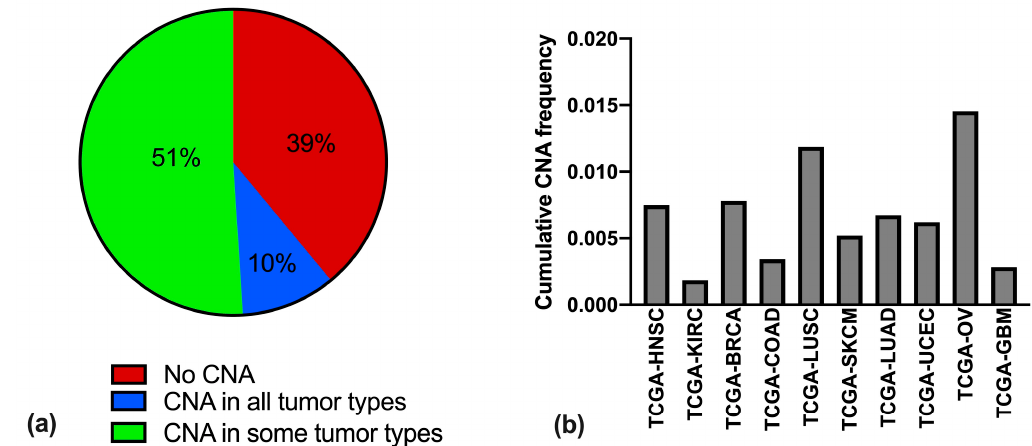
Figure 1. Occurrence of snoRNA / host gene alterations in the ten groups of cancers. ( a ) Percentage of copy number alterations (CNA) in snoRNA / host gene couples, across ten di ff erent tumor types (breast invasive carcinoma (BRCA), colorectal adenocarcinoma (COAD), glioblastoma multiforme (GBM), head and neck squamous cell carcinoma (HNSC), lung adenocarcinoma (LUAD), lung squamous cell carcinoma (LUSC), ovarian serous cystadenocarcinoma (OV), uterine corpus endometrial carcinoma (UCEC), skin cutaneous melanoma (SKCM), and kidney renal clear cell carcinoma (KIRC)) divided between couples never undergoing CNA (red), undergoing CNA in all tumors (blue), and undergoing CNA only in some tumor types (green). ( b ) Cumulative CNA frequency in the ten tumor types, calculated in each series as total number of CNA events divided for the total number of possible alterations (i.e., the number of snoRNA / host gene couples (295) times the number of patients in the